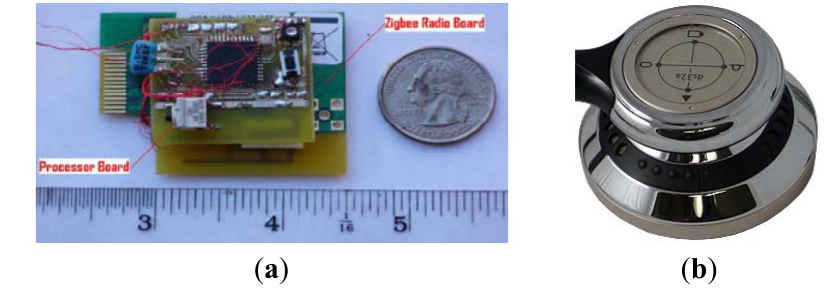
Figure 6. ( a ) The Actual Wireless Platform; ( b ) Electronic Stethoscope Model